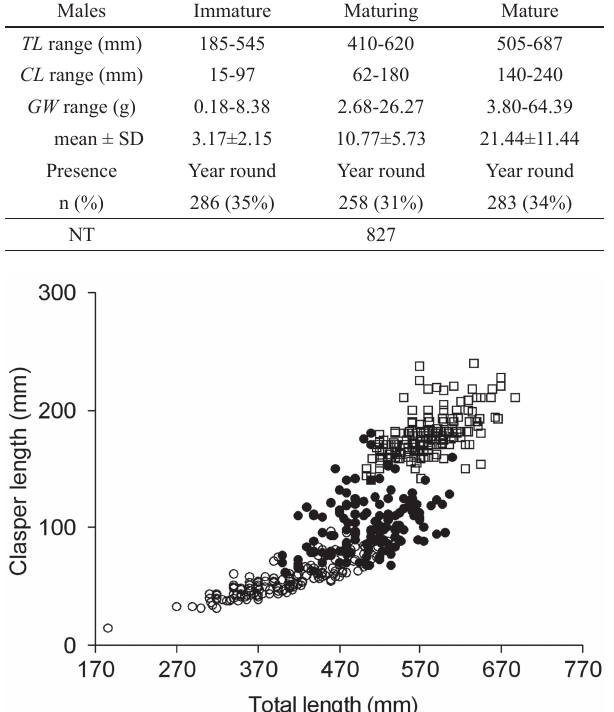
Tab. 3. Characteristics of the maturity stages of males of Sympterygia bonapartii from San Matías Gulf (Argentina). TL = total length; CL = clasper length; GW = weight of the paired testes.